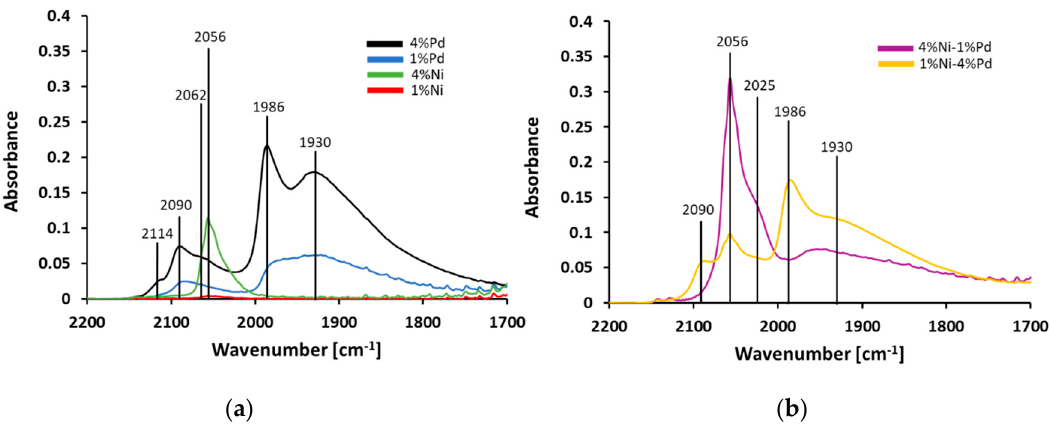
Figure 3. FTIR spectra of CO adsorbed on the surface of ( a ) the monometallic and ( b ) the bimetallic catalysts recorded under CO pressure.